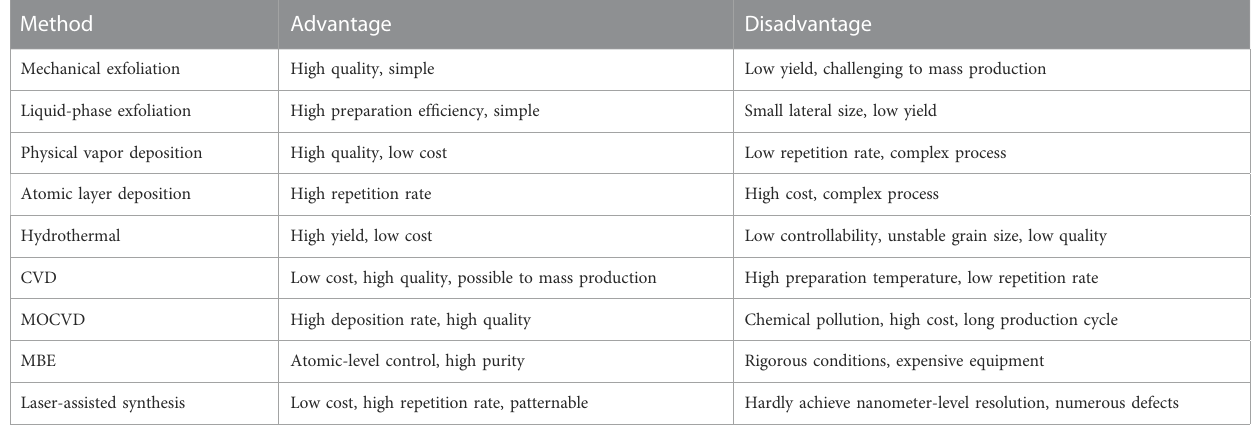
TABLE 1 Summary of preparation methods of 2D